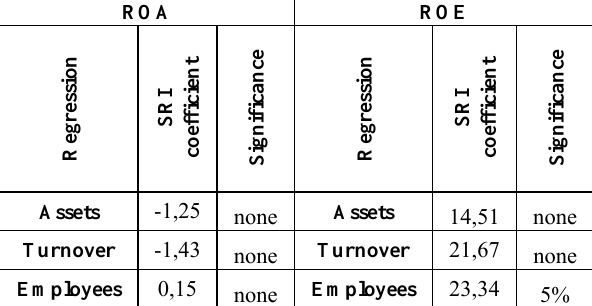
Table 5: Regression results following McWilliams &